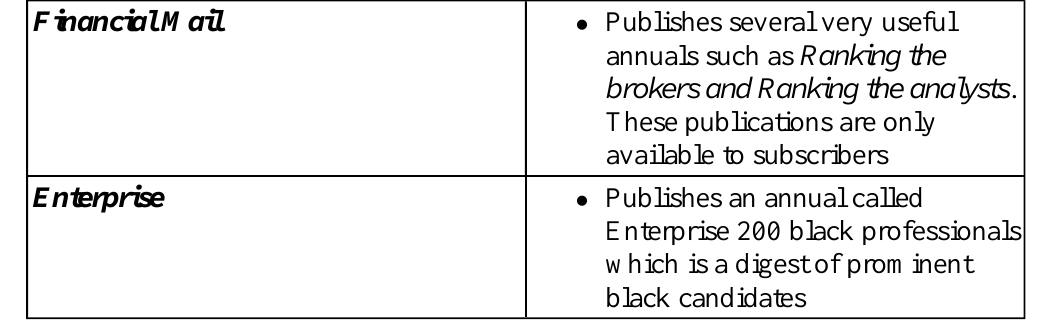
Movers and shakers